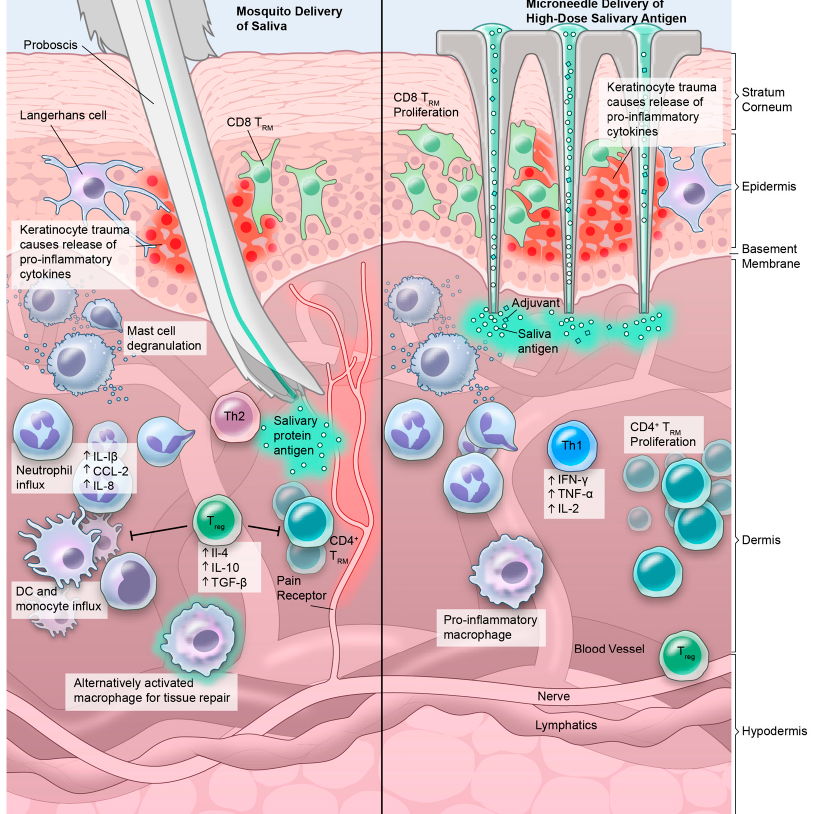
Figure 2. Cutaneous immune environment in the setting of mosquito saliva (left) and saliva vaccination (right). Left panel : The mosquito proboscis deposits saliva antigen into the dermis while also causing keratinocyte trauma and activation. Saliva antigens lead to mast cell degranulation, increase in Th2-dominant cytokines, and subsequent transient influx of neutrophils, dendritic cells and monocytes. Regulatory T-cells in the skin inhibit T cell activation and modulate antigen presenting cell function. Right panel : Microneedle administration of salivary antigen causes similar keratinocyte trauma and activation of cytokine release. Supratherapeutic doses of salivary antigen with Th1-promoting adjuvant are released into the dermis without activating nociceptors. A pro-inflammatory response is initiated resulting in macrophage activation and Th1 polarization. Theoretically, proliferation of salivary antigen-specific CD4 + tissue-resident memory (T RM ) cells proliferation in the dermis, and possibly proliferation of CD8 + T RM cells in the epidermis, could allow for rapid, protective T RM responses to any future antigen